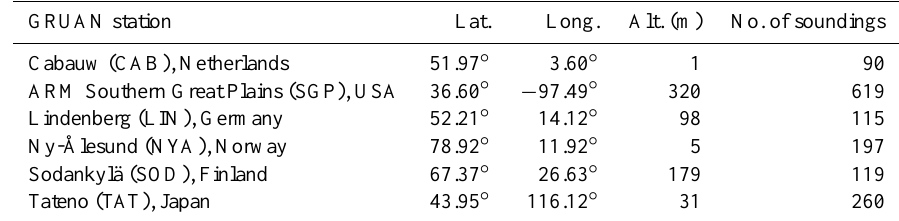
Table 1. GRUAN stations with available sounding data within 100km and 120min GOME-2 overpass. GRUAN station